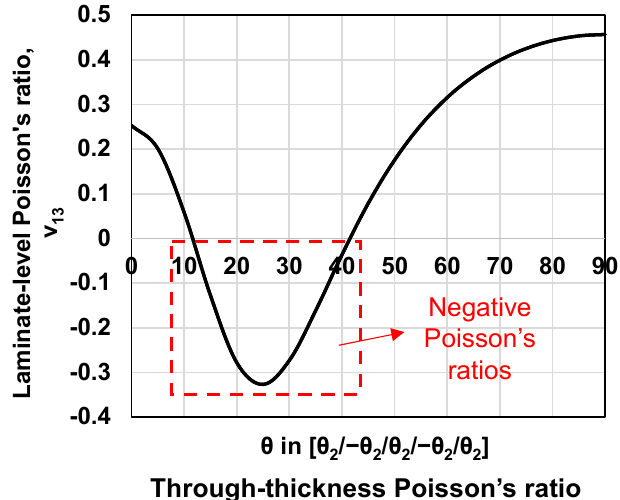
Figure 2. Predicted layups to produce laminate-level through-thickness negative Poisson’s ratios in IM7/977-3 CFRP composite laminates with a layup of [ θ 2 / − θ 2 / θ 2 / − θ 2 / θ 2 ] as the ply angle, θ , changes from 0 to 90 degrees.